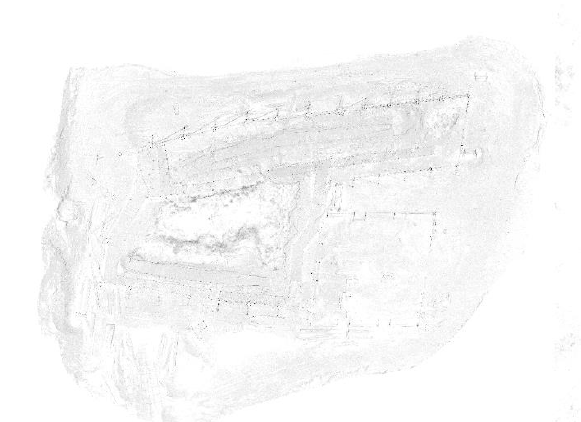
Figure 11. Dense point cloud data of a cultural heritage